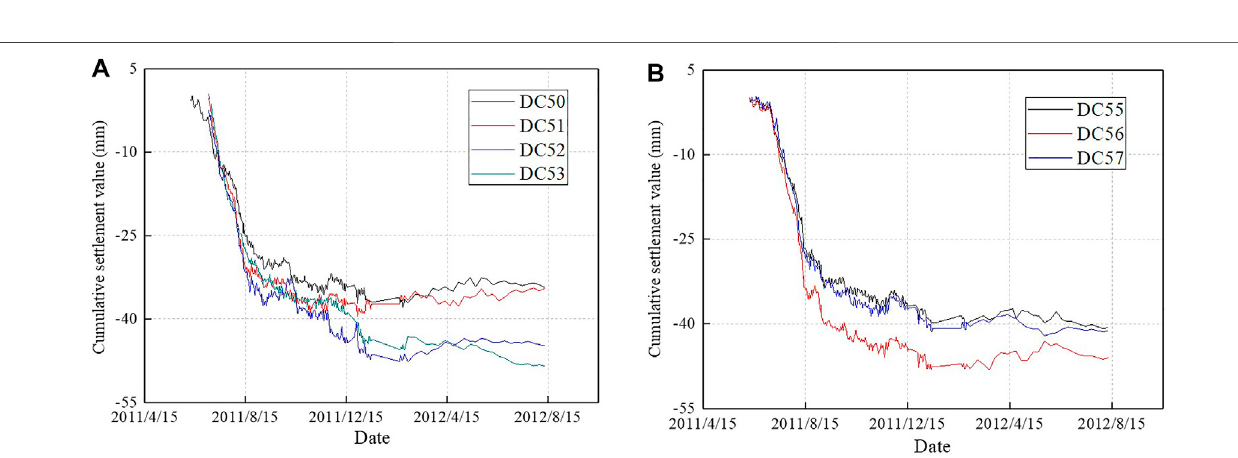
Frontiers in Earth Science |